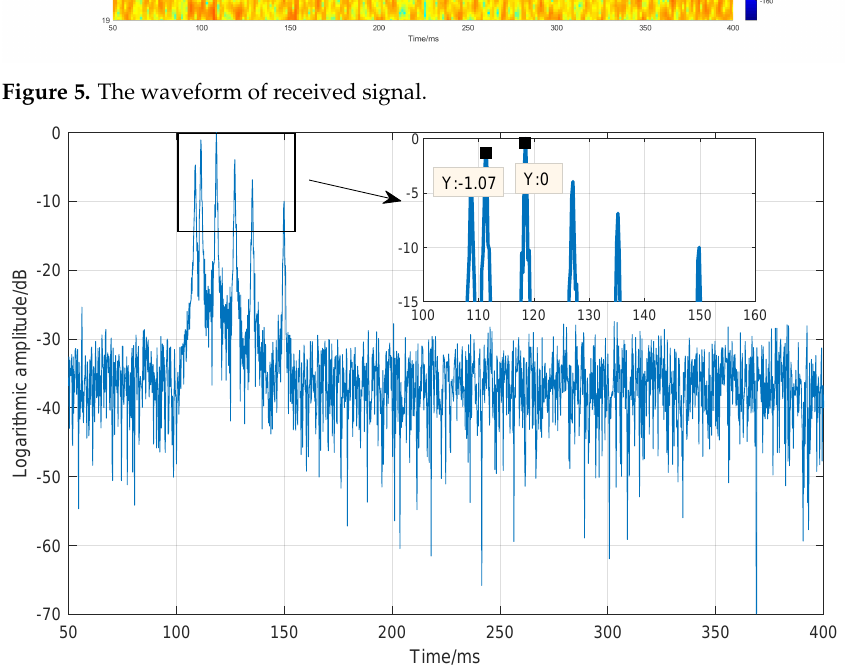
Figure 6. The result of received signal processed by the optimal order